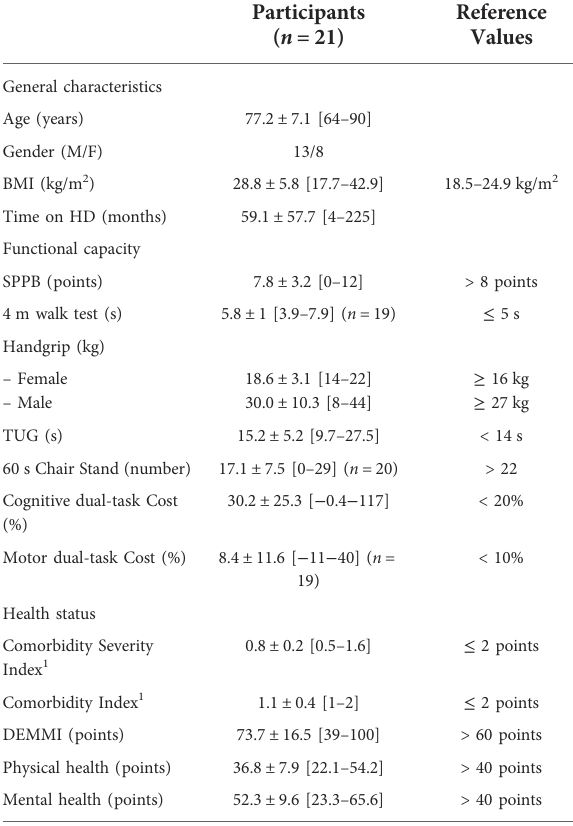
TABLE 1 Baseline demographic, clinical and functional data: mean± SD [range] characteristics of the participants. Where not speci fi ed, all 21 participants are